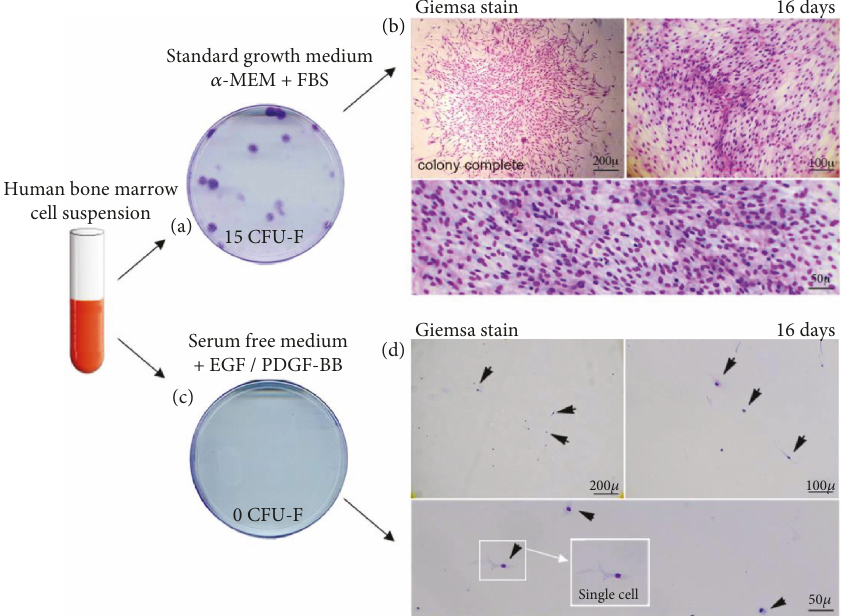
Figure 2: Clonal growth depends on serum. Samples of clonal nucleated cells from unsorted human BM were plated and cultured in 100 mm dishes ( 8 3 × 10 3 cell/cm 2 , n = 5 ). Photographs of culture dishes showing proliferation of primary BM CFU-F, cultured in standard CFU-F growth medium supplemented with 20% FBS (a) or cultured in SDM and supplemented with EGF/PDGF (10 ng/ml) (c). After 2 weeks of culture, well-developed colonies were observed in serum-supplemented cultures (a, b). In contrast, no colony developed in SDM; single cells remained attached with an intact nucleus and an intact cytoplasm (arrows), for at least 2 weeks, as demonstrated by Giemsa staining, but did not proliferate or generate any clone in serum-free medium (c, d). Results are derived from 5 independent experiments and from 5 di ff erent donors. FBS: Fetal Bovine Serum; EGF: Epidermal Growth Factor; PDGF-BB: Platelet-Derived Growth Factor. Scale bars represent 50 μ m, 100 μ m, and 200 μ